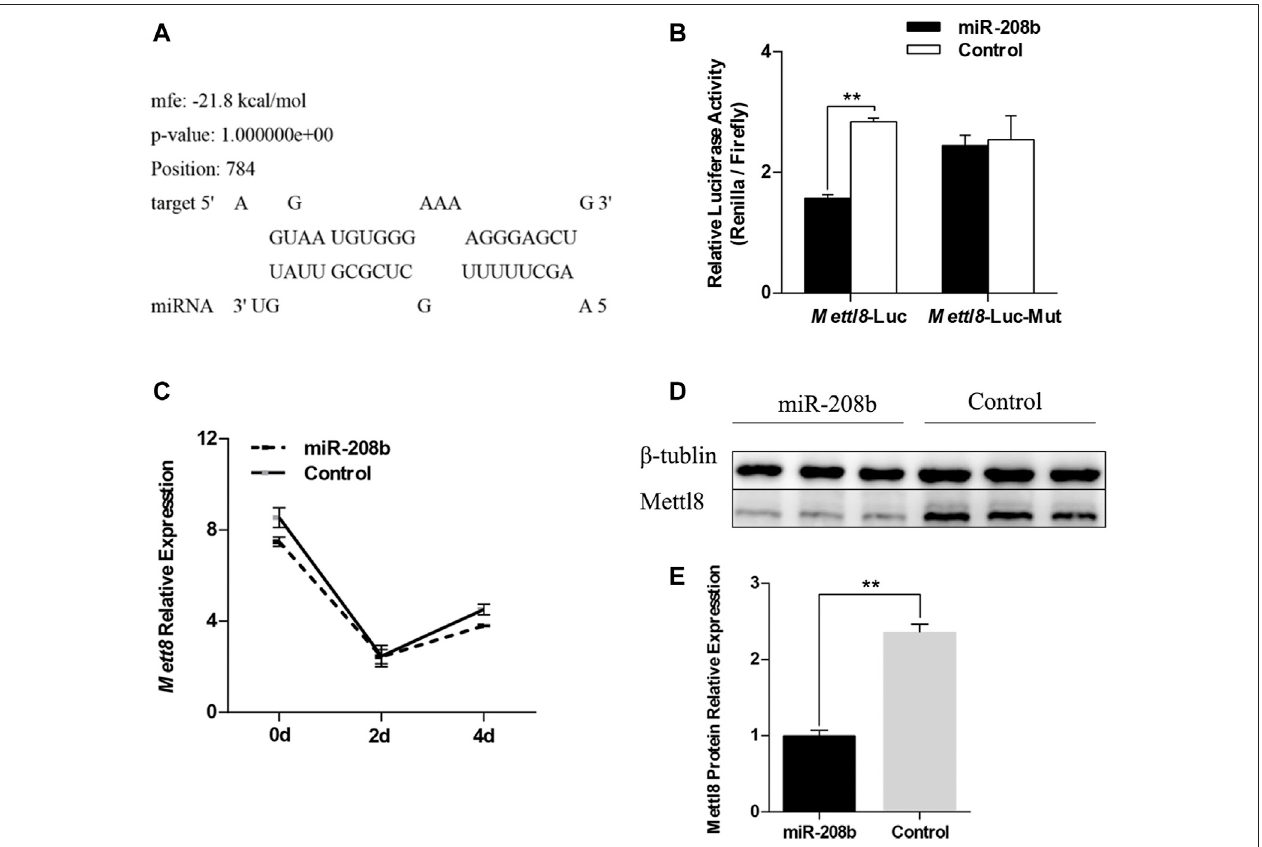
FIGURE 4 | Veri fi cation of the targeting relationship between miR-208b and Mettl8. (A) The binding site of miR-208b and Mettl8 3 ′ UTR sequence. (B) Results of dual luciferase reporter assay. Mettl8-Luc: wild-type plasmid; Mett18-Luc-Mut: Mettl8 mutant plasmid. The ordinate is the relative luciferase activity (renilla luciferase activity/ fi re fl yluciferaseactivity).MiR-208brepresentsC2C12cellstransfectedwithmiR-208bmimicstoachievetheeffectofmiR-208bover-expression. (C) Changesin Mettl8 mRNA expression level after miR-208b overexpression in C2C12 cells during myogenic differentiation. (D) Western blot results of Mettl8 protein after miR- 208b overexpression. (E) Relative expression level of Mettl8 protein calculated using Image J software. Statistical comparisons are performed using multiple t -tests in (B – C) and using unpaired t -tests in (E) . ** p <